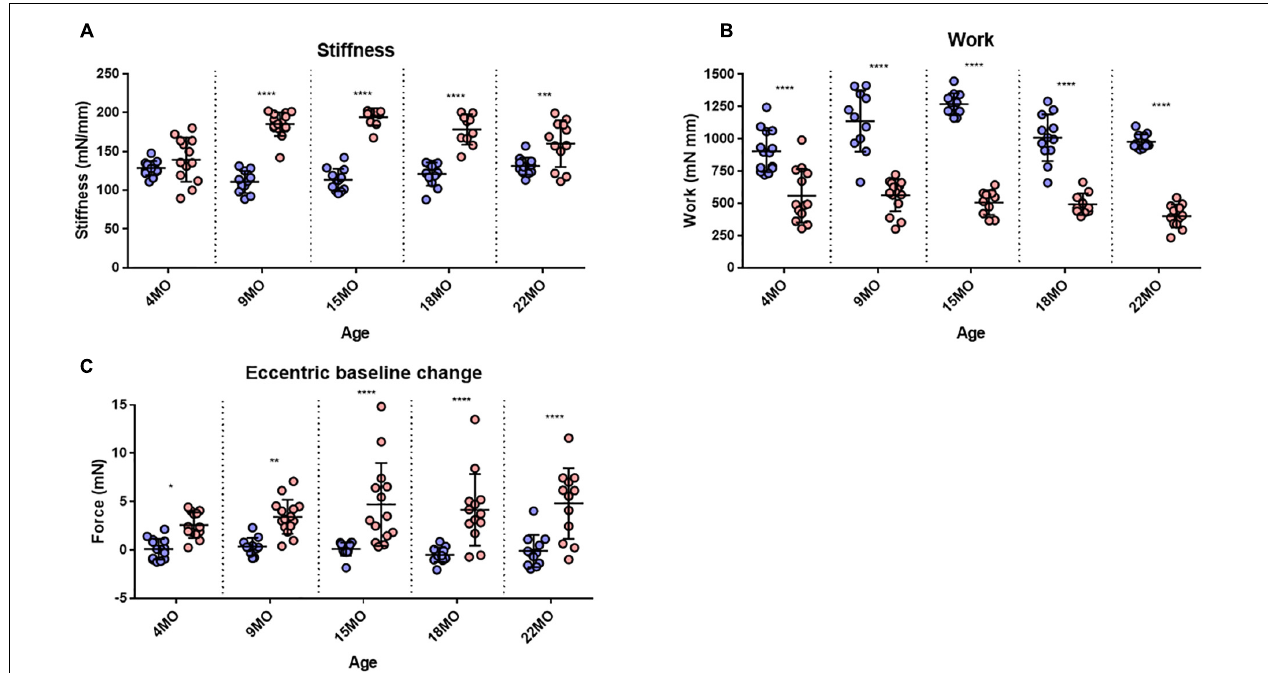
FIGURE 8 | Stiffness, Work done and baseline force. (A) Interleaved scatterplots showing the EDL muscle stiffness calculated during the first 20% EC across 4-month ( n = 14 control; n = 13 mdx ), 9-month ( n = 11 control; n = 15 mdx ), 15-month ( n = 12 control; n = 10 mdx ), 18-month ( n = 12 control; n = 10 mdx ), and 22-month ( n = 12 control; n = 12 mdx ) age groups. (B) Interleaved scatterplots showing the work done by EDL muscles calculated during the first 20% EC across 4-month ( n = 14 control; n = 13 mdx ), 9-month ( n = 11 control; n = 15 mdx ), 15-month ( n = 12 control; n = 10 mdx ), 18-month ( n = 12 control; n = 10 mdx ), and 22-month ( n = 12 control; n = 12 mdx ) age groups. (C) Interleaved scatterplots showing the baseline force change post EC for mdx and littermate control EDL muscles across 4-month ( n = 14 control; n = 13 mdx ), 9-month ( n = 11 control; n = 14 mdx ), 15-month ( n = 9 control; n = 14 mdx ), 18-month ( n = 12 control; n = 10 mdx ), and 22-month ( n = 12 control; n = 12 mdx ) age groups. In each interleaved scatterplot group the horizontal line indicates the mean value ± SD. Statistical differences between age groups are displayed above the graph, statistical differences displayed within graphs are differences between genotypes assessed by two-way ANOVA, post hoc analysis using Sidak’s multiple comparisons test. **** P < 0.0001, ***0.0001 < P < 0.001, **0.001 < P < 0.01, and *0.01 < P < 0.05.